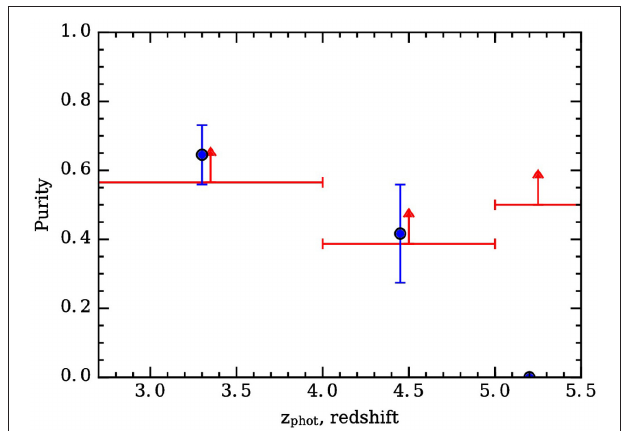
FIGURE 2 | Circles with Poissonian errorbars indicate the purity of the quasar candidates whose spectra have been taken at AZT-33IK or BTA. The arrows indicate the estimated lower limit for the purity of the K16 catalog relative to the objects with known (from literature or SDSS) spectroscopic